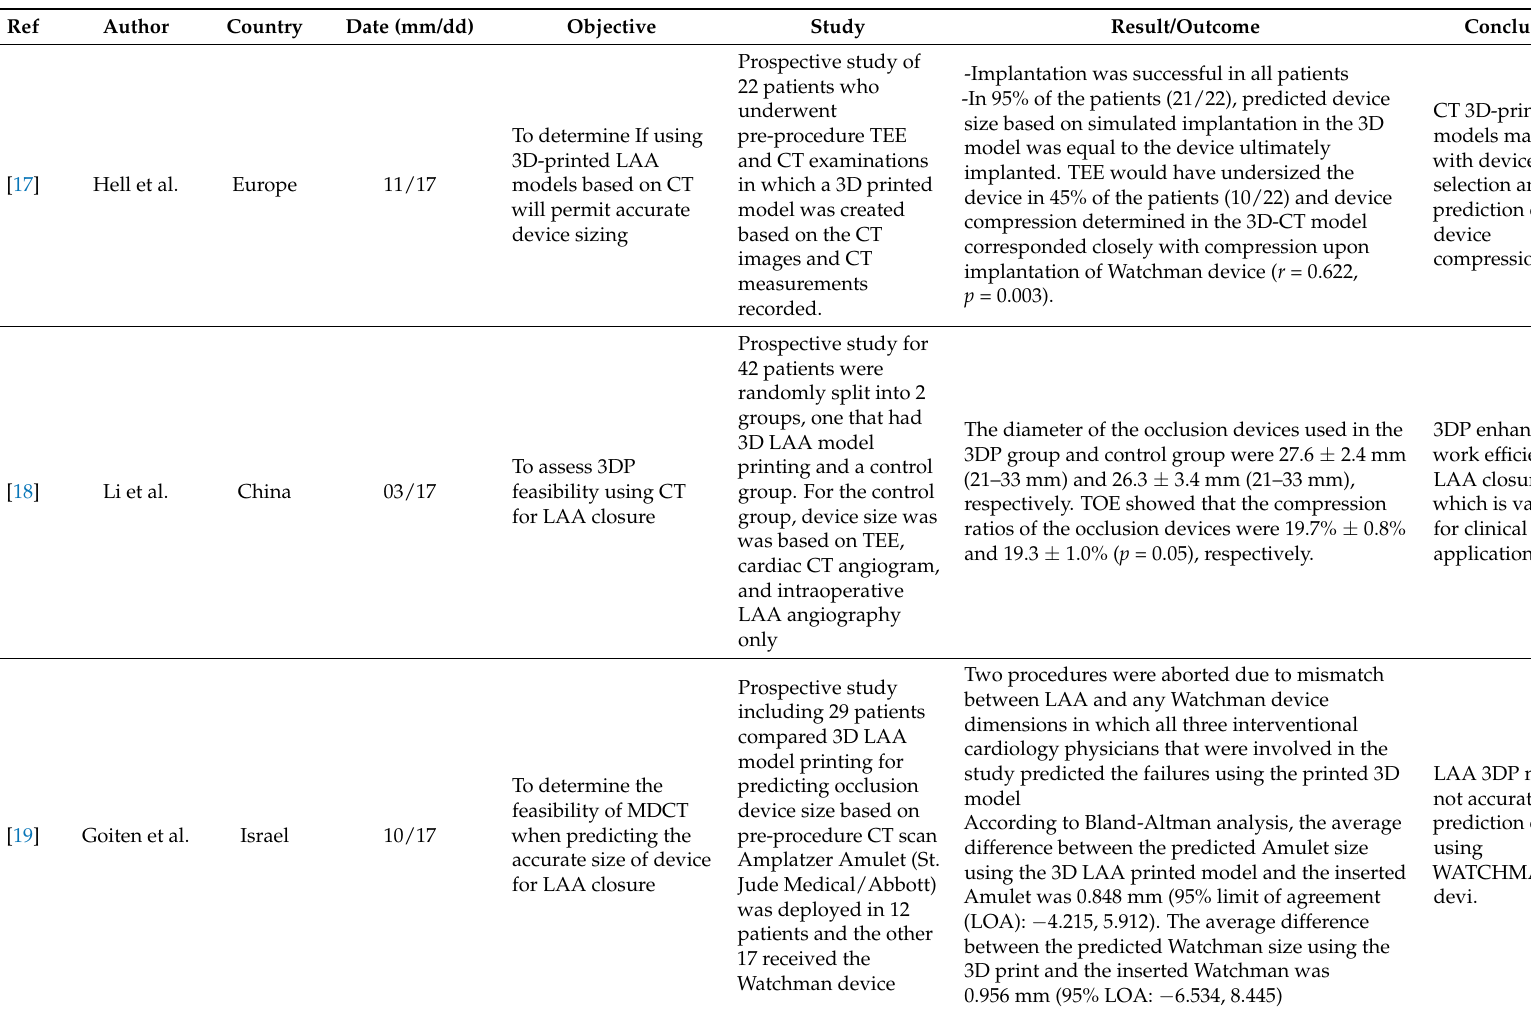
Table 5. Literature review summary table of CT 3D printing in the preprocedural assessment of the left atrial